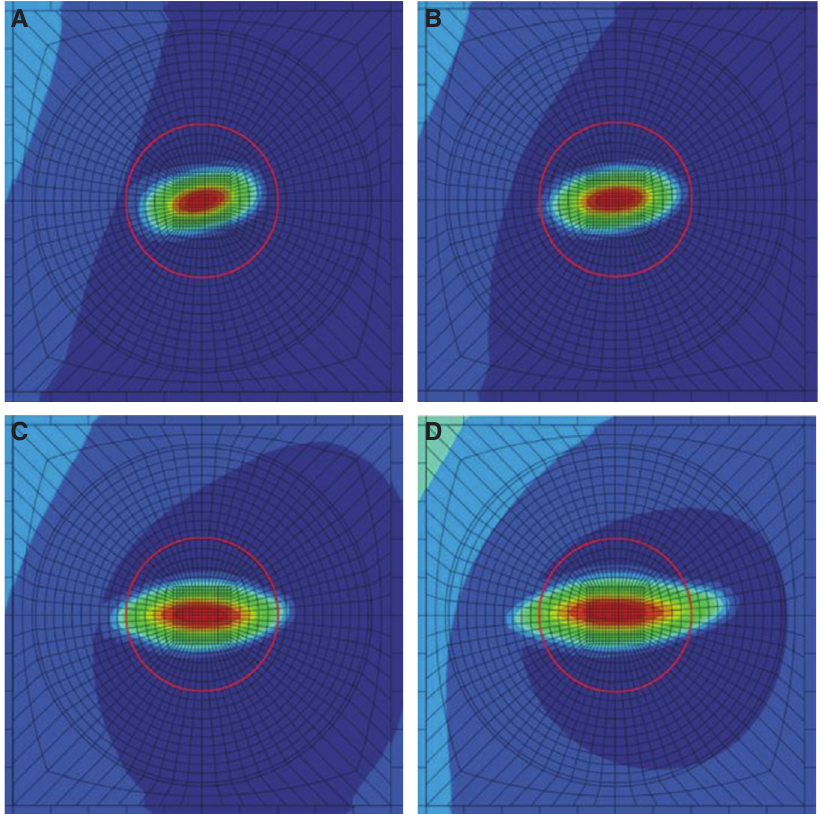
Figure 5 Evolution of the buckling of the delaminations during compression loading.